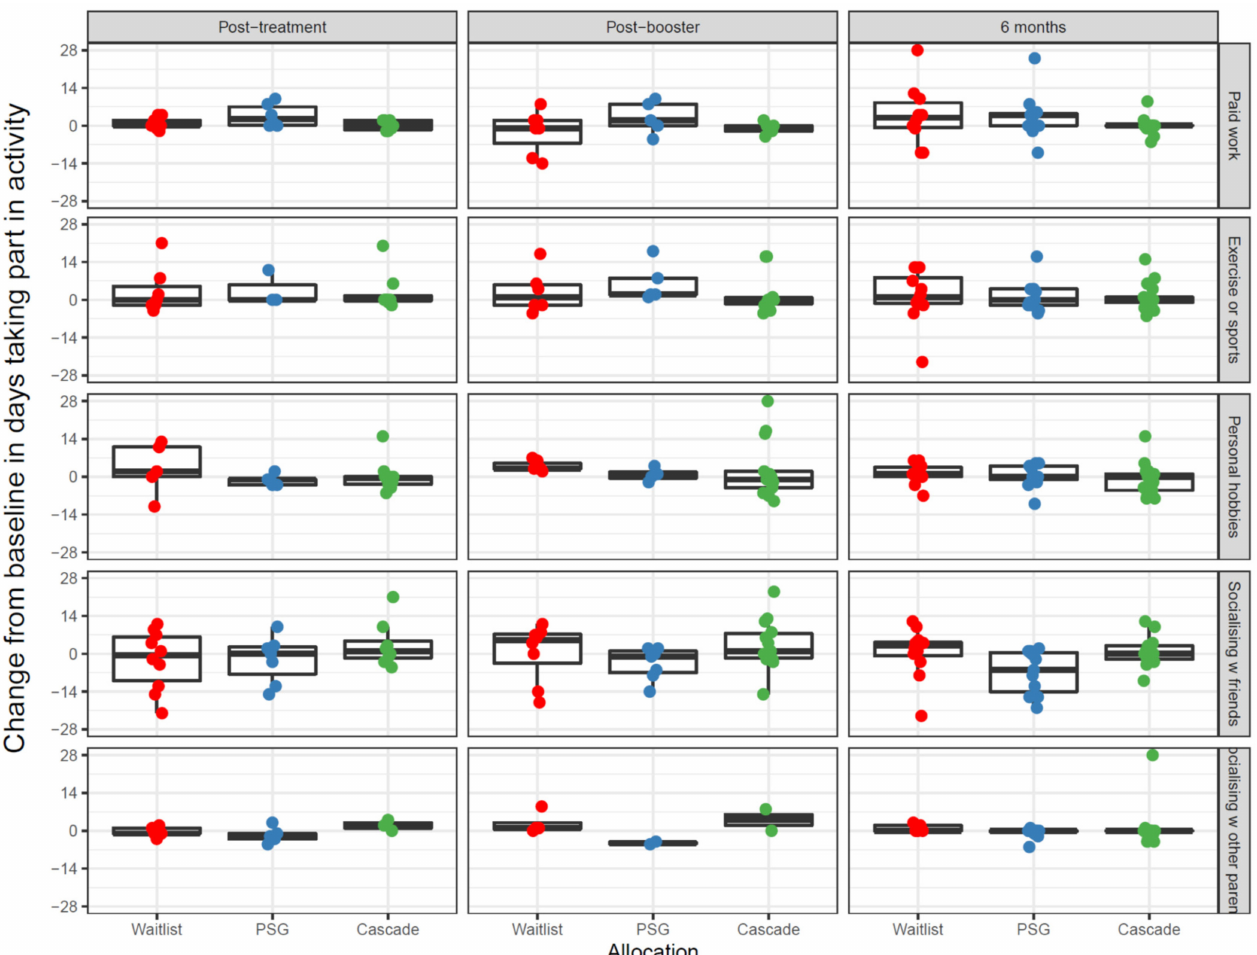
Figure 8. Change in the number of days parents engaged in productive activities in the last four weeks from baseline (Q1) at each time point for each parent. Notes: PSG: Peer-support